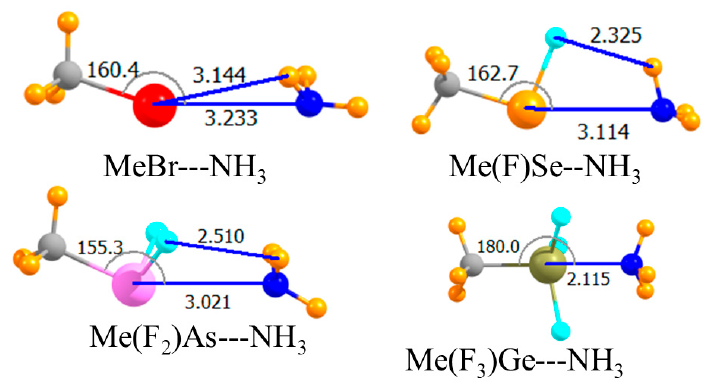
Figure 4. Optimized geometries of complexes involving a fluorinated Lewis acid with CH 3 opposite N. Intermolecular distances are in Å, angles in deg.